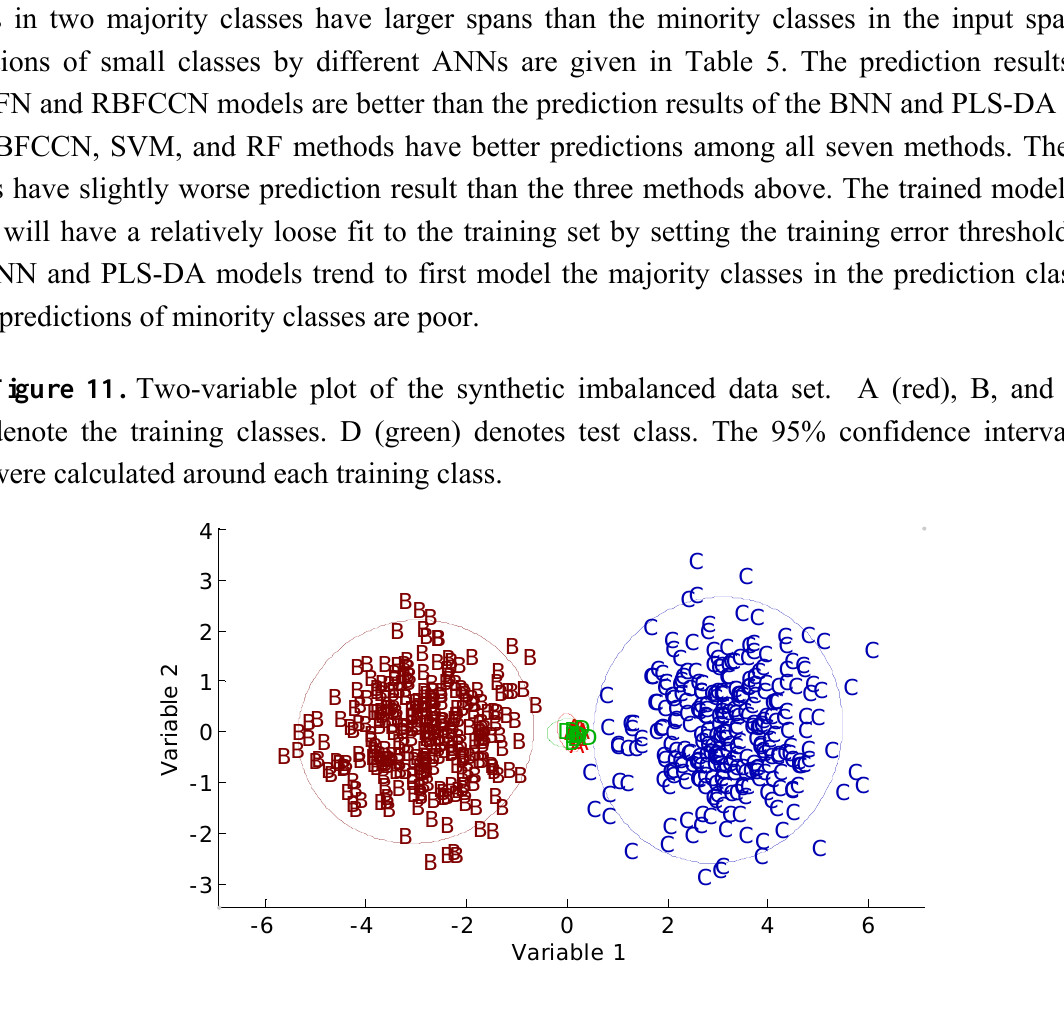
Table 5. Average numbers of correctly predicted objects with 95% confidence intervals from class D in an imbalanced data set by different models. All modeling methods were reconstructed 30